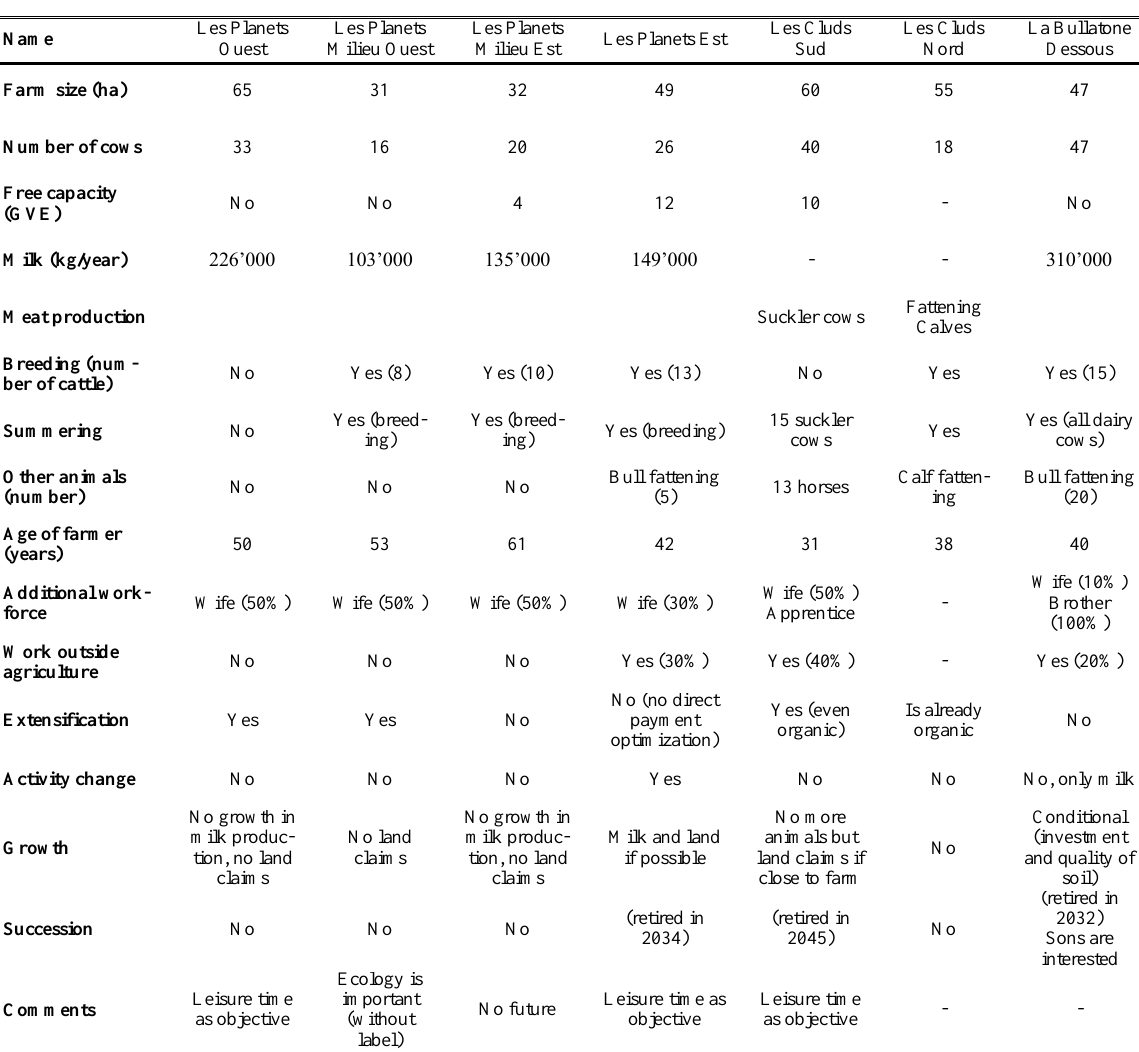
Table A2 : Characteristics of farms in